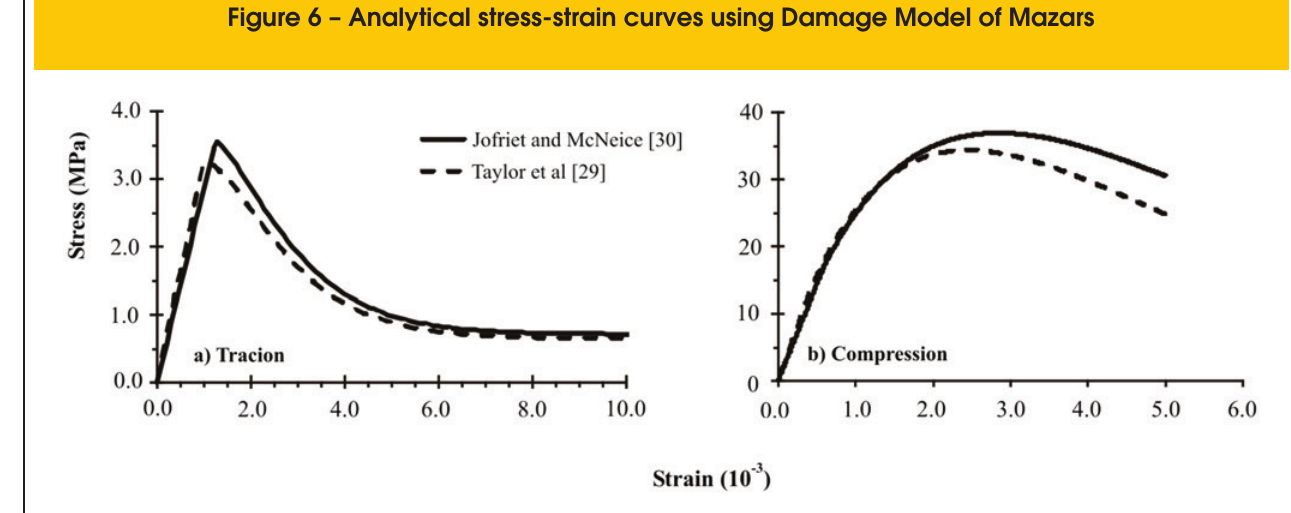
Figure 6 – Analytical stress-strain curves using Damage Model of Mazars